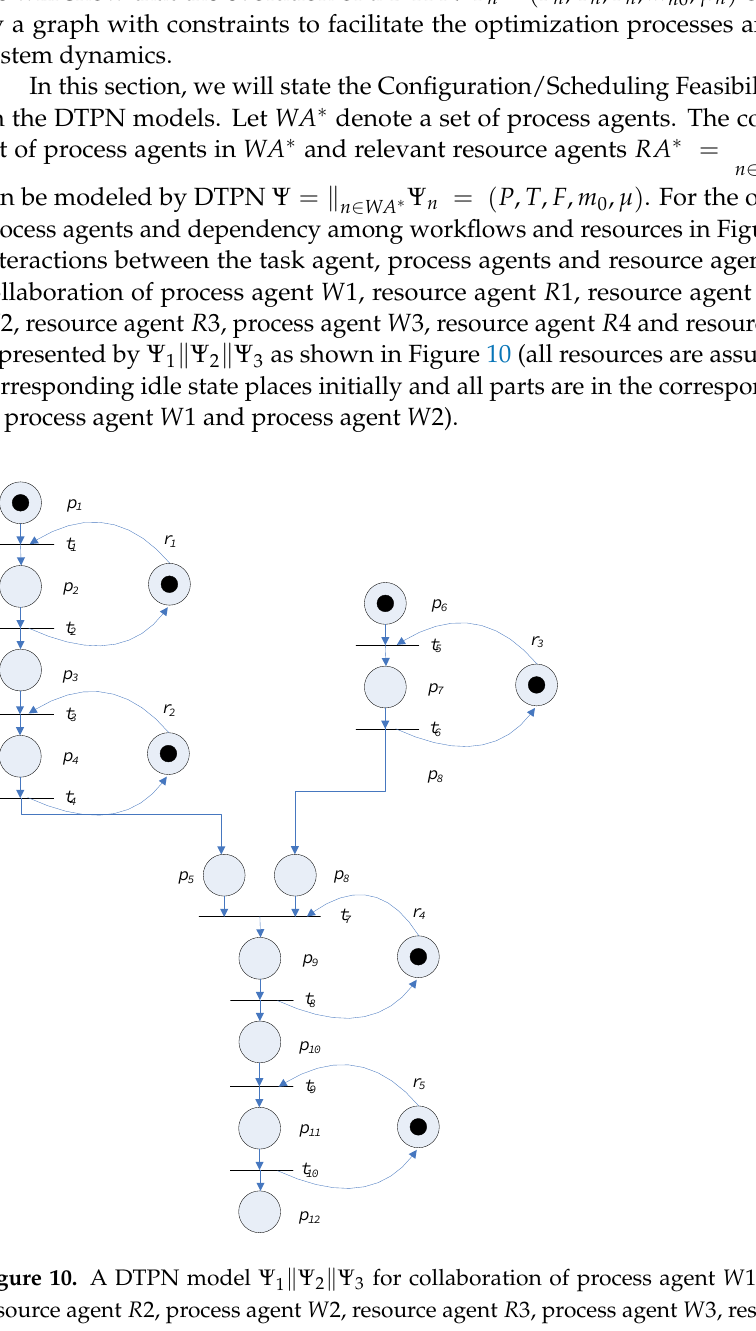
Figure 10. A DTPN model Ψ 1 (cid:107) Ψ 2 (cid:107) Ψ 3 for collaboration of process agent W 1, resource agent R 1, resource agent R 2, process agent W 2, resource agent R 3, process agent W 3, resource agent R 4, and resource agent R